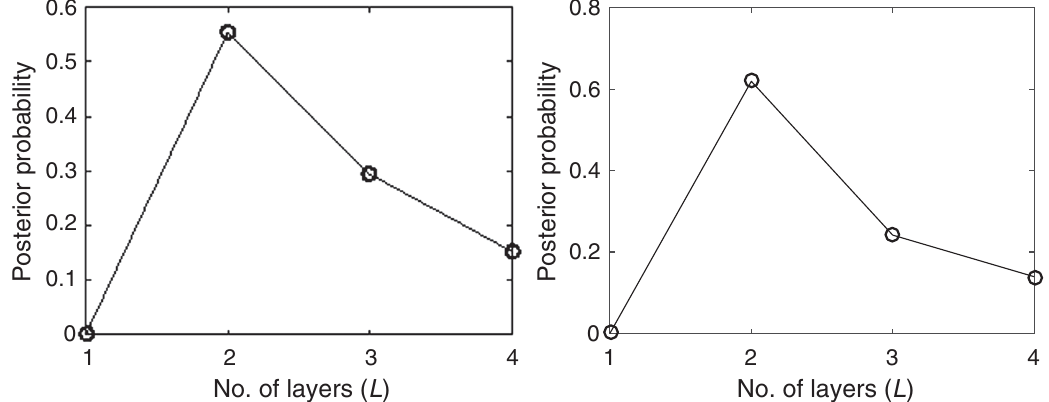
FIG. 18. (Left panel) Posterior probability P ( L j X ð 1 ∶ N Þ ) as a function of the number of layers L , computed from a trajectory of 10 4 time steps generated using a model with L ¼ 2 layers and parameters 1 − r ¼ 0 . 89 , T ð 1 Þ ¼ 0 . 14 , and T ð 2 Þ ¼ 0 . 56 . Computation is performed using deterministic grid integration. The algorithm clearly picks out the correct model L ¼ 2 . (Right panel) Similar results as for the left panel but using the NPMC algorithm instead of the deterministic integration, which is much faster and allows us to reconstruct the full